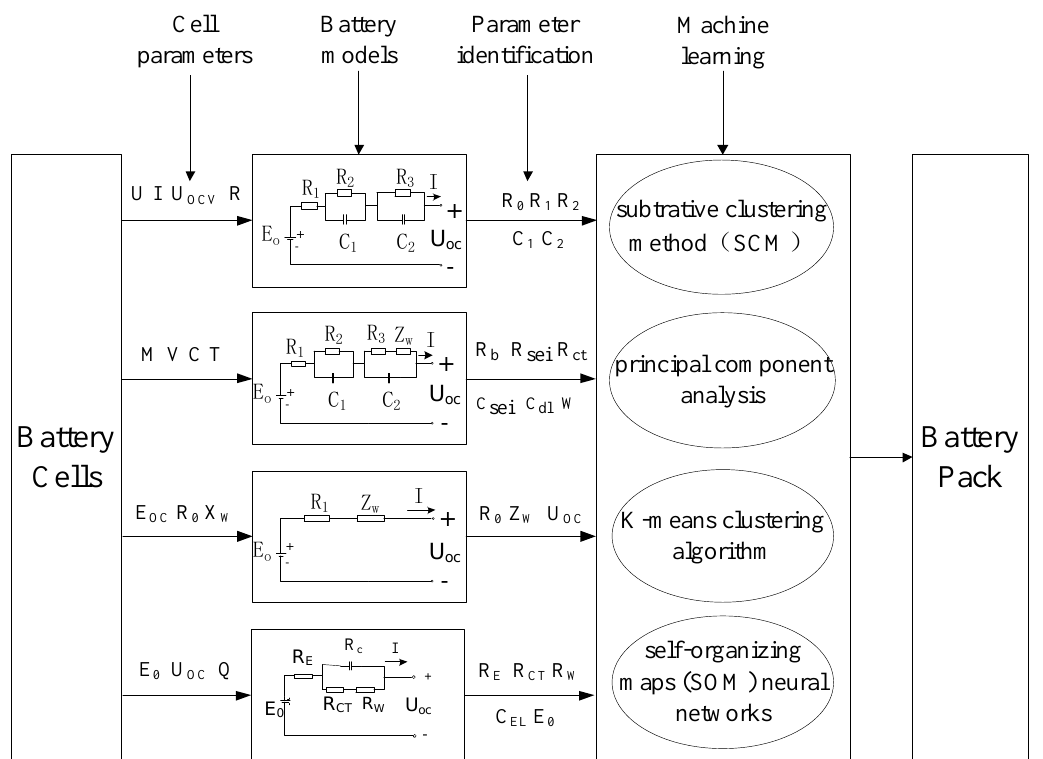
Figure 7. Schematic diagram of the model-based battery sorting method.